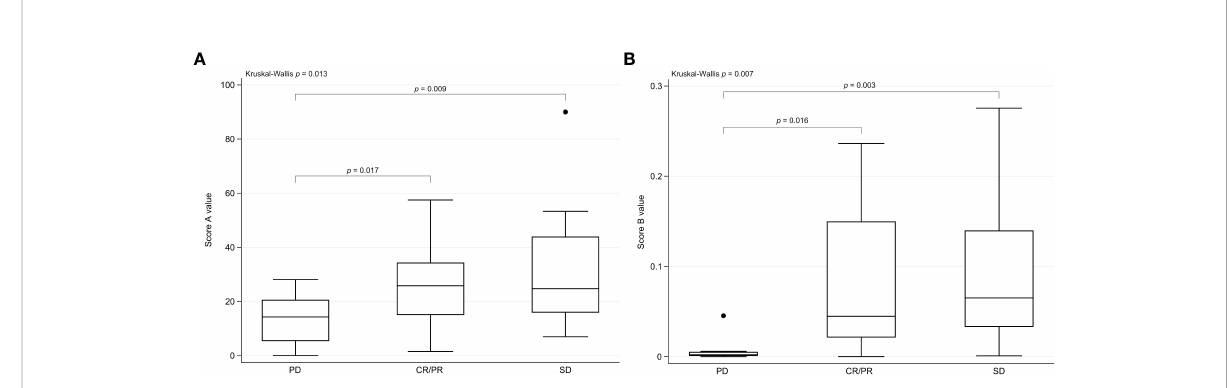
FIGURE 1 Scores A and B in correlation with response. (A) Score A values are presented as box plots with median (line) in relation to response to IT (CR/ PR, SD, and PD) at fi rst staging. A statistically signi fi cant difference for Score A was detected in patients with CR/PR vs . PD ( p = 0.017) as well as in patients with SD vs . PD ( p = 0.009). In patients with PD, lower score values were detected. (B) Score B values are presented as box plots with median (line) in relation to response to IT (CR/PR, SD, and PD) at fi rst staging. A statistically signi fi cant difference for Score B was detected in patients with CR/PR vs . PD ( p = 0.016) as well as in patients with SD vs . PD ( p = 0.003). In patients with PD, lower score values were detected. Score A , Tregs ÷ (CD4 + /CD8 + ratio); Score B , Tregs × HLA-DR + CD4 + T cells × PD1 + CD8 + T cells; IT , immunotherapy; CR , complete response; PR , partial response; SD , stable disease; PD , progressive disease.